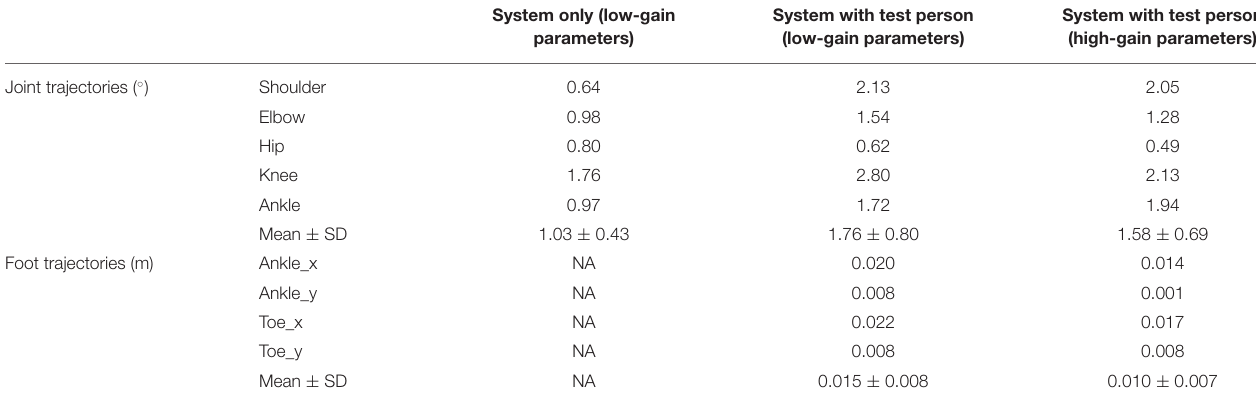
TABLE 2 | RMSE of the joint and segmental trajectories.